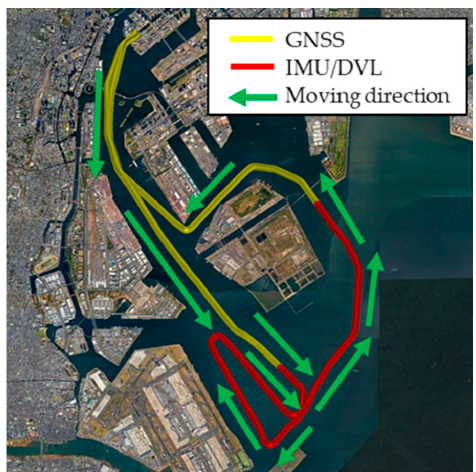
Figure 7. Voyage tracking using Google